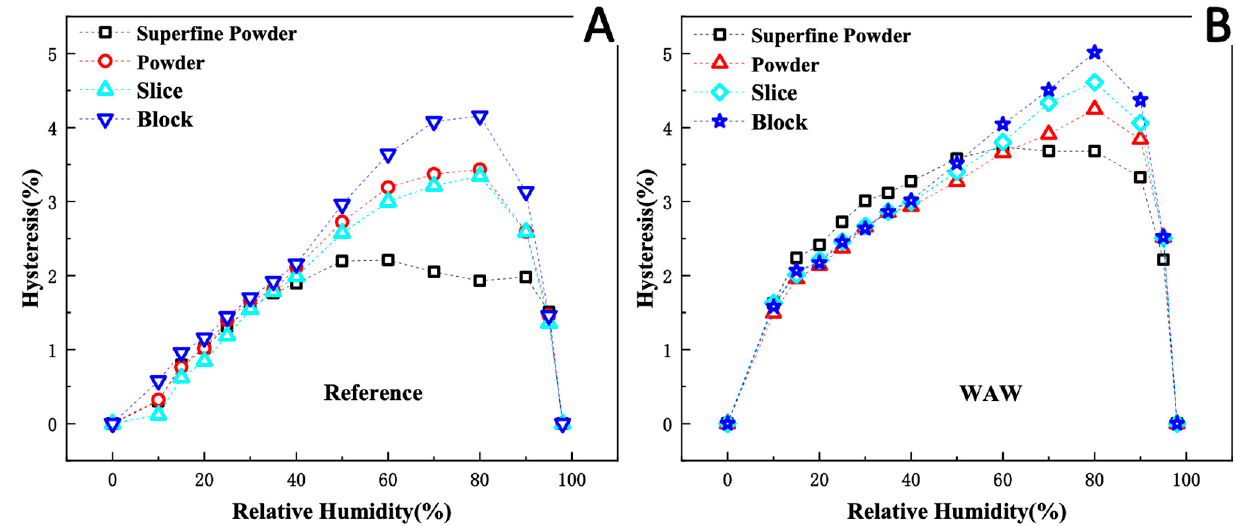
Figure 3. Hysteresis values of reference samples ( A ) and WAW samples ( B ) versus RH.